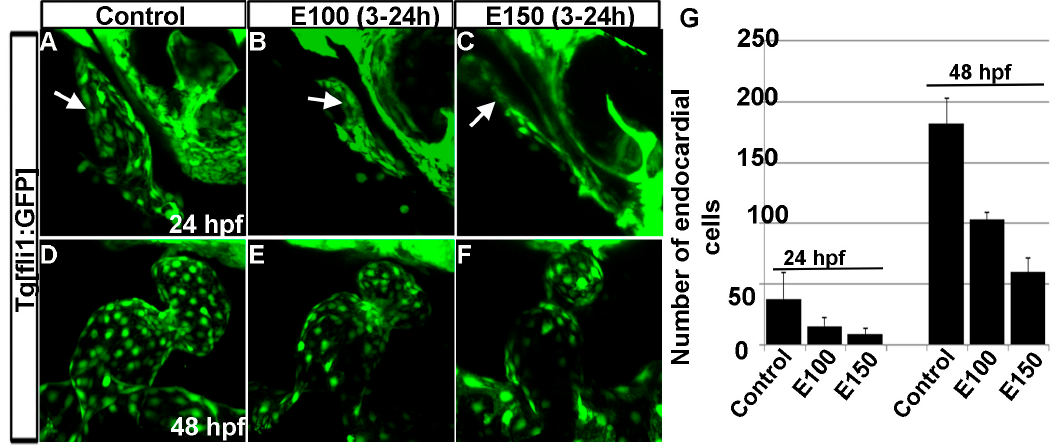
Figure 5. Ethanol exposure reduced endocardial cell numbers. ( A – C ) Tg ( fli1 : EGFP ) embryos showed endocardial lining in the linear heart tube in control embryo ( A ) and in ethanol-exposed embryos ( B , C ) at 24 hpf; ( D – F ) Tg ( fli1 : EGFP ) embryos showed normal-shaped endocardium in the control embryo ( D ) and deformed endocardium with fewer endocardial cells in ethanol-exposed embryos at 48 hpf ( E , F ); ( G ) Graph shows the quantification of the endocardial cells at 24 and 48 hpf. White arrow: endocardial lining.